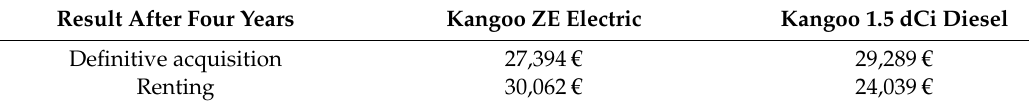
Table 3. Comparison between two light commercial